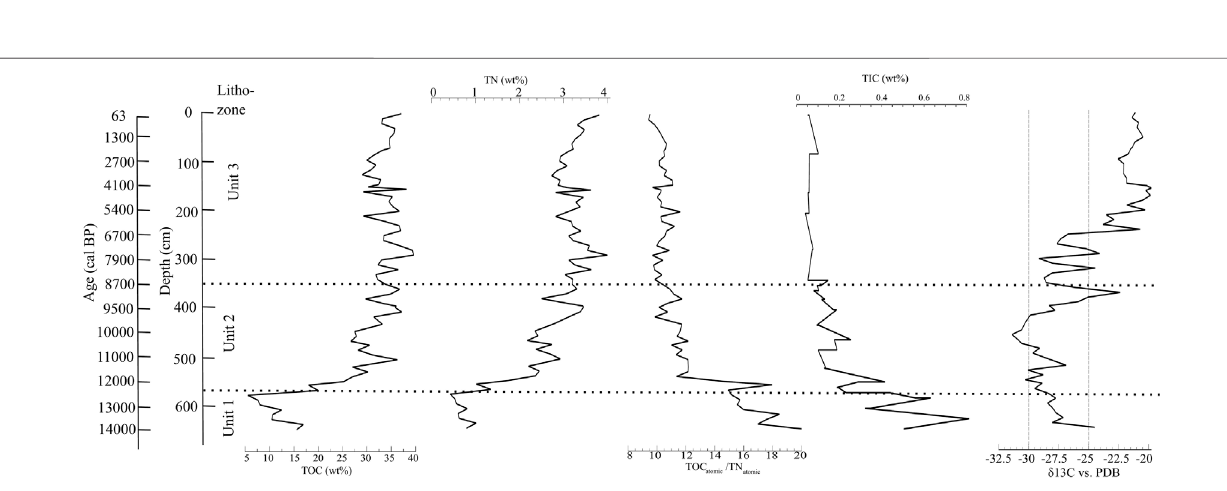
Frontiers in Earth Science |